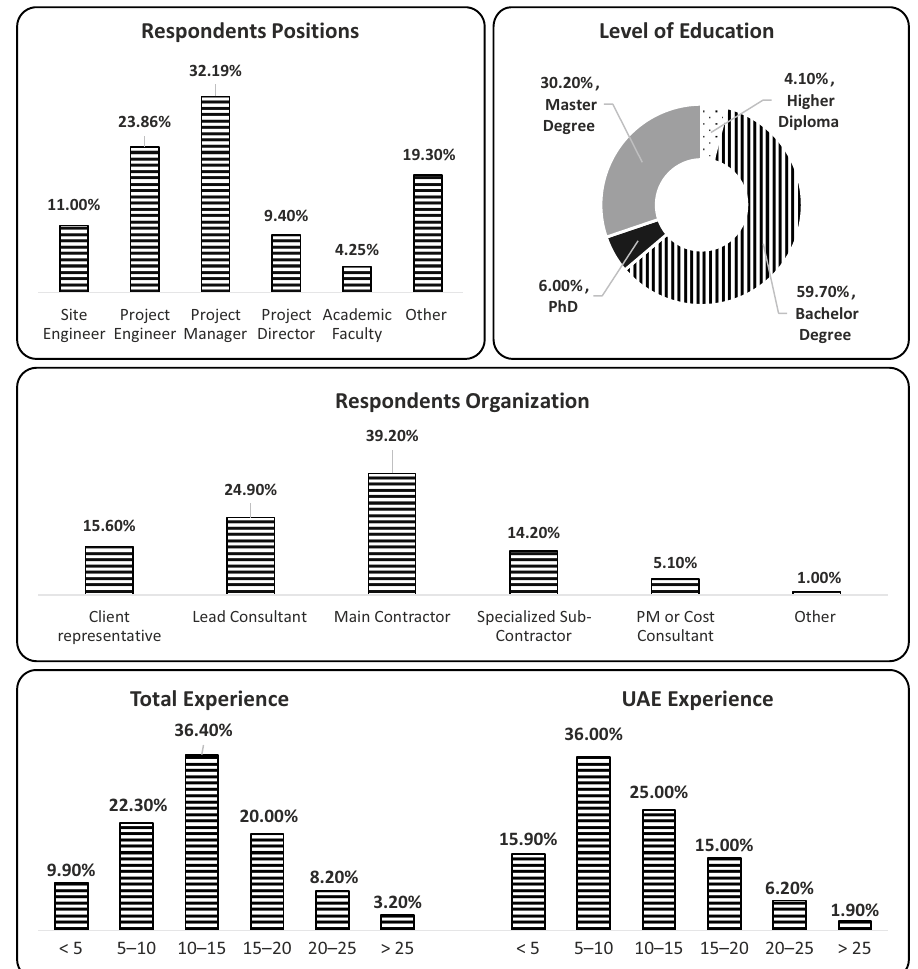
Figure 3. Profile of